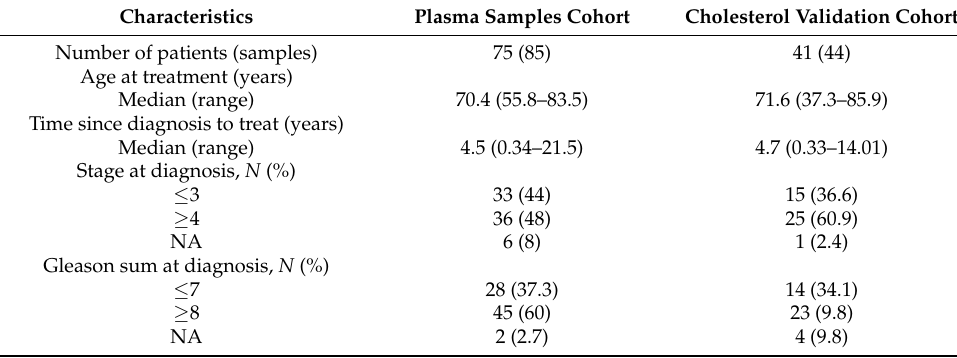
Table 1. Patients’